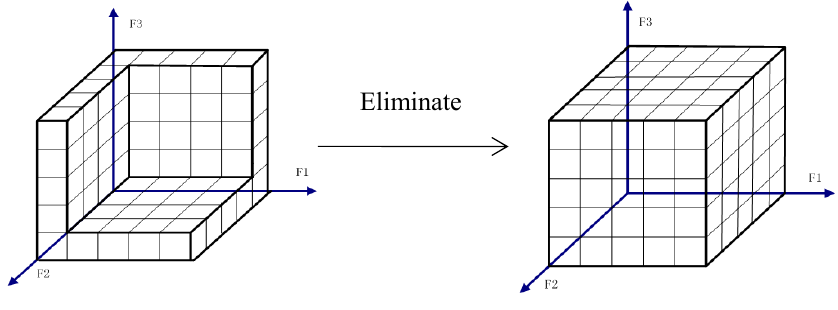
Figure 1. The schematic diagram of iterated elimination of strictly dominant